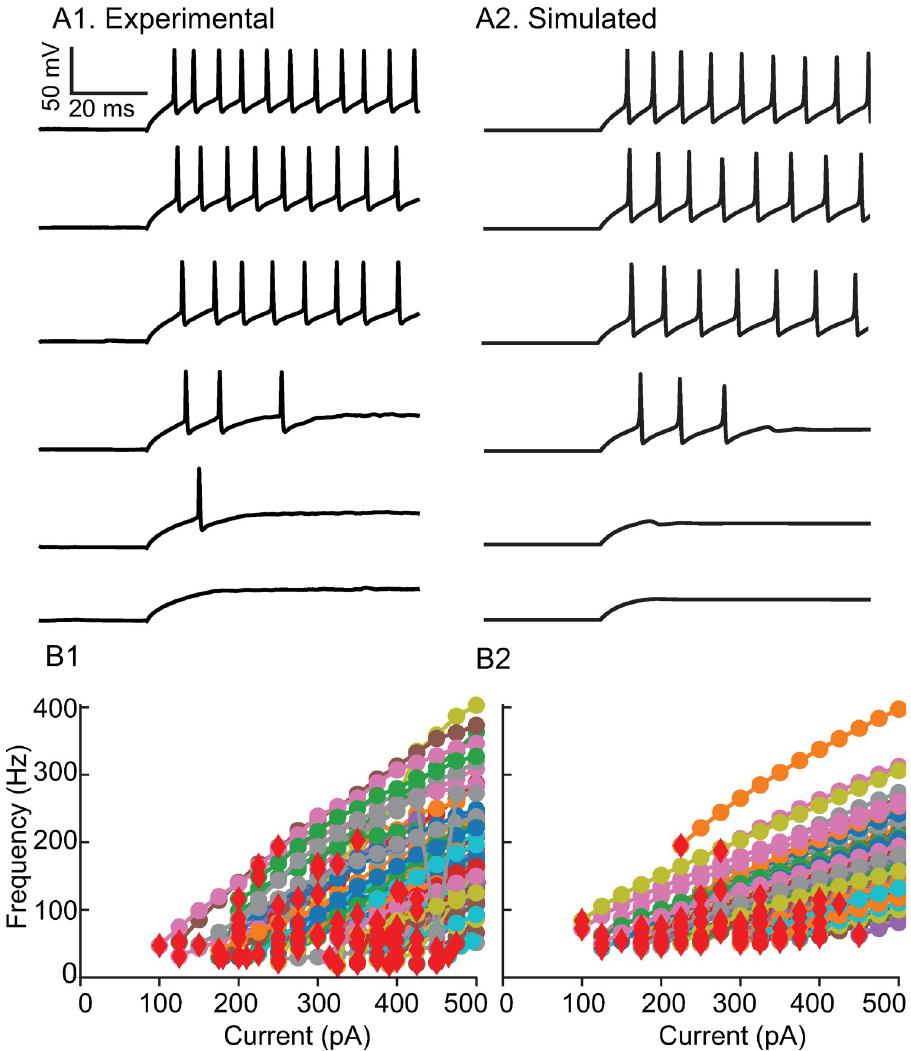
Fig 1. Calibration of active properties. A. Responses of representative neurons to depolarizing current steps from 300 pA to 425 pA in 25 pA increments. A1. mEC PV+ interneuron. A2. Model neuron. Parameters as in Table 1 except E